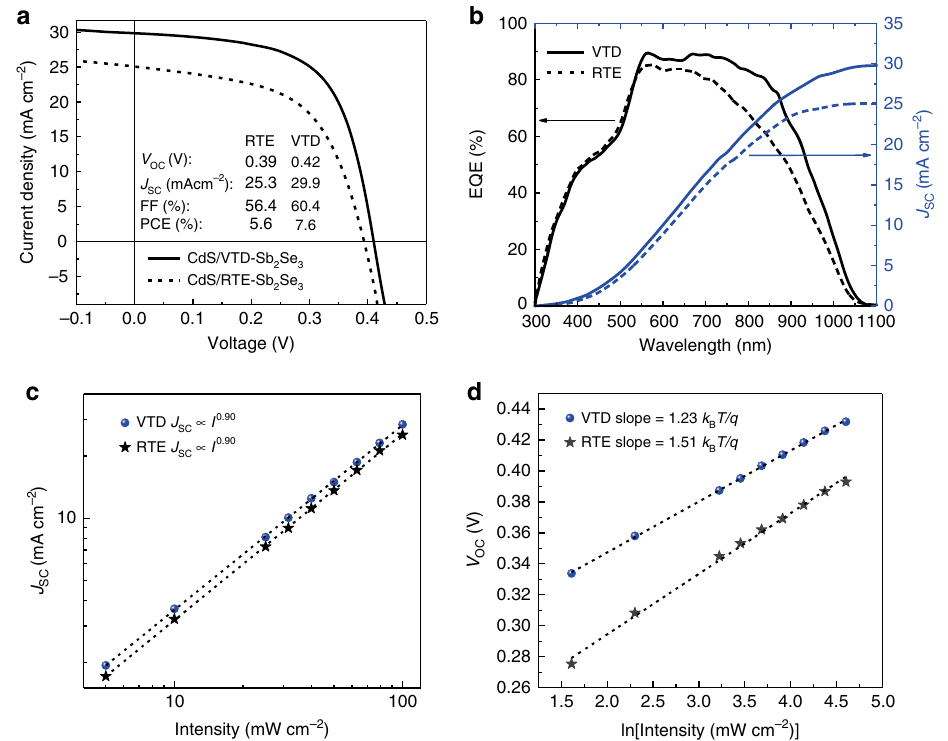
Fig. 3 Device performance and light intensity-dependent J SC and V OC of devices. a The light J-V curves of VTD- and RTE-fabricated devices under AM1.5 G illumination. The J-V curve of the VTD-fabricated device with certi fi ed ef fi ciency of 7.6% (area = 0.091 cm 2 ) was measured by National Institute of Metrology on 1 September 2017. The calibration certi fi cate number is GXtc2017-1987 (Supplementary Fig. 3). b EQE and integrated J SC of the VTD- and RTE-fabricated devices. Light intensity-dependent c J SC and d V OC . Neutral-density fi lters (THORLABS) were used to control the light